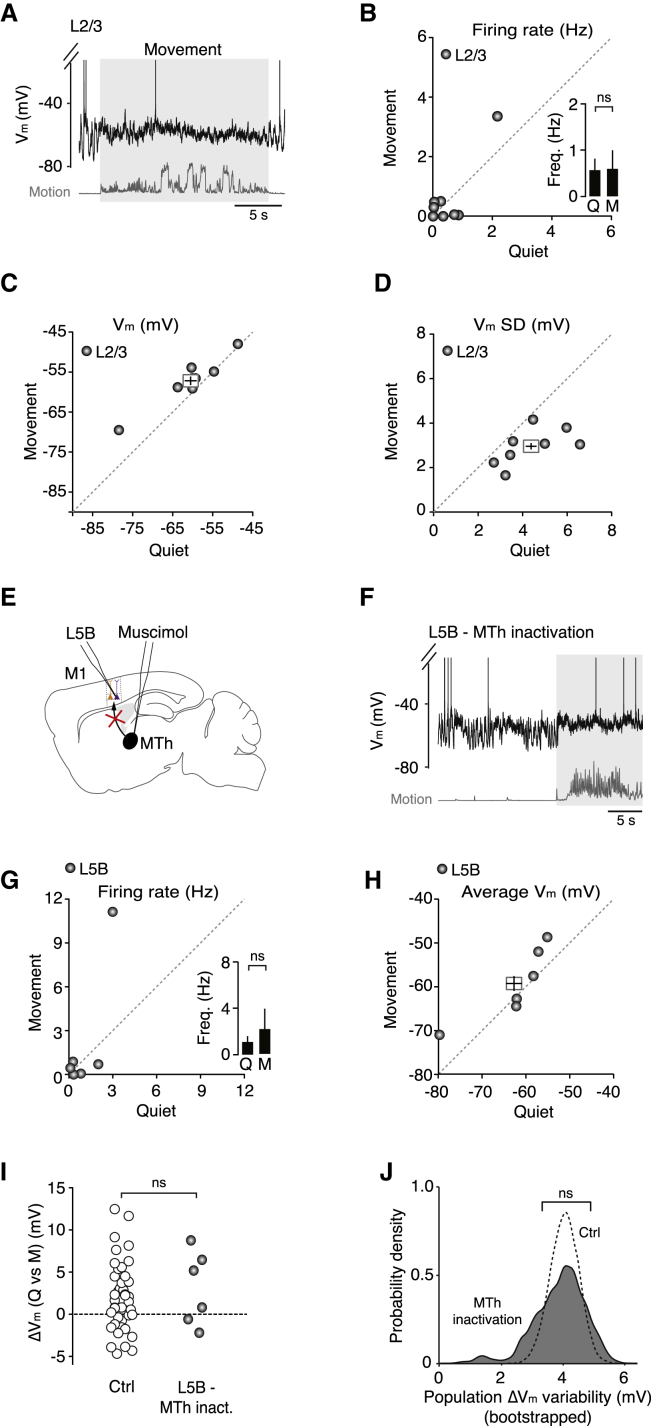
Effect of Descending L2/3 and Ascending Motor Thalamic Input on L5B Pyramidal Neuron Vm Dynamics during Quiet Wakefulness and Movement(A) Representative voltage trace shows an L2/3 pyramidal neuron during quiet wakefulness and movement (gray shading).(B–D) Average firing rate (B), mean Vm (C), and Vm SD (D) in L2/3 pyramidal neurons (gray symbols, n = 8) before and after movement. Filled circles represent data from individual neurons while square symbols represent mean ± SEM. Inset in (B) depicts average L2/3 pyramidal neuron firing rate during quiet wakefulness (Q) and movement (M). ns, non-significant.(E) Schematic representation shows an L5B pyramidal neuron recording after inactivation of ipsilateral motor thalamus (MTh) by local perfusion of muscimol.(F) Representative voltage trace showing an L5B pyramidal neuron after ipsilateral inactivation of motor thalamus.(G and H) Average firing rate (G) and mean Vm (H) in L5B pyramidal neurons after motor thalamic inactivation (n = 6). Filled circles represent data from individual neurons while the square symbol in (H) represents the mean ± SEM. Inset in (G) depicts the average firing rate of L5B neurons during quiet wakefulness (Q) and movement (M). ns, non-significant.(I) Change in average Vm (ΔVm) during movement in the presence (Ctrl, open symbols, n = 41) and absence of motor thalamic input (gray symbols, n = 6). Control data (Ctrl) were taken from Figure 1 for comparison. Mann-Whitney U test; ns, non-significant.(J) Probability density distributions of ΔVm variability across the L5B pyramidal neuron population (Ctrl and MTh inact.), measured as the SD of the ΔVm distributions shown in (I) (Population ΔVm SD) using bootstrap analysis (10,000 bootstrap replicates). Black dashed line represents population ΔVm variability distribution in control (Ctrl), and gray shading represents population ΔVm variability distribution following motor thalamic inactivation. Control data (Ctrl) were taken from Figure 1 for comparison. F test; ns, non-significant.See also Figure S5.